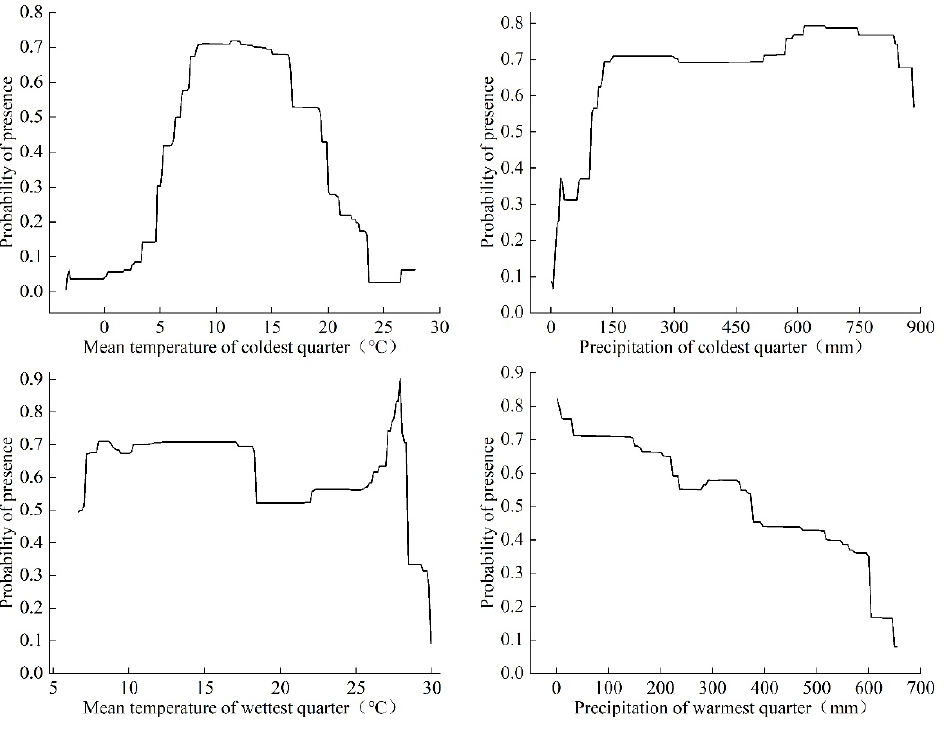
Figure 5 . Probability of presence for important bioclimatic variables for Linepithema humile .